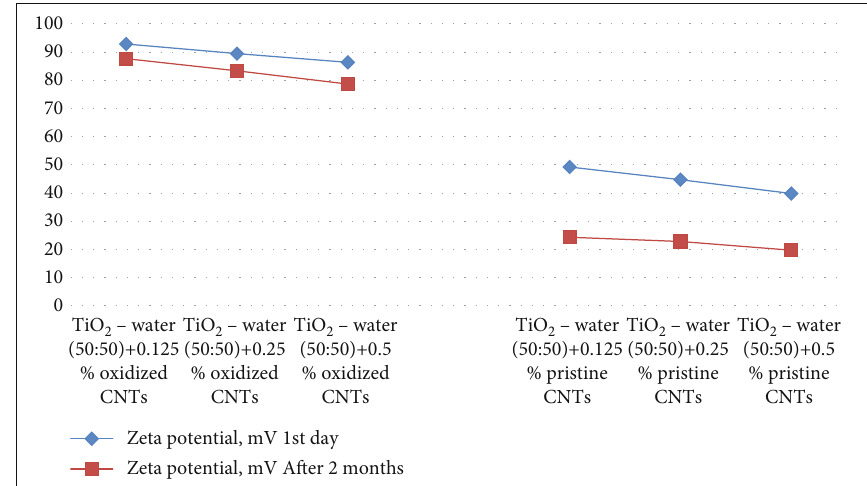
Figure 12: Zeta potential changes of nano fl uids including pristine and oxidized CNTs during 60 days for a 50:50 TiO